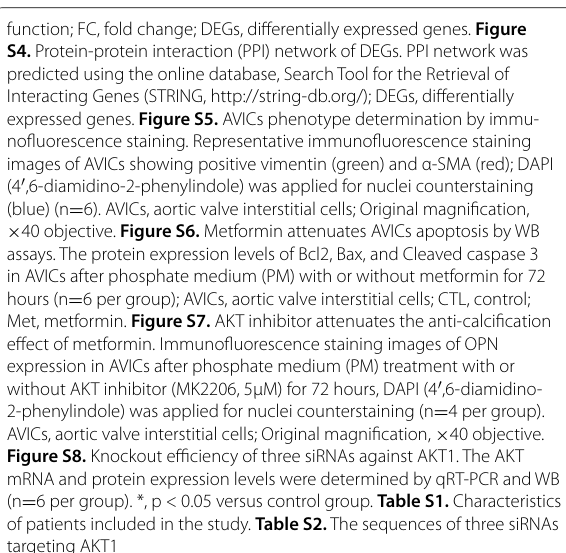
function; FC, fold change; DEGs, differentially expressed genes. Figure S4. Protein-protein interaction (PPI) network of DEGs. PPI network was predicted using the online database, Search Tool for the Retrieval of Interacting Genes (STRING, http://string-db.org/); DEGs, differentially expressed genes. Figure S5. AVICs phenotype determination by immu- nofluorescence staining. Representative immunofluorescence staining images of AVICs showing positive vimentin (green) and α-SMA (red); DAPI (4 ′ ,6-diamidino-2-phenylindole) was applied for nuclei counterstaining (blue) (n 6). AVICs, aortic valve interstitial cells; Original magnification, = 40 objective. Figure S6. Metformin attenuates AVICs apoptosis by WB × assays. The protein expression levels of Bcl2, Bax, and Cleaved caspase 3 in AVICs after phosphate medium (PM) with or without metformin for 72 hours (n 6 per group); AVICs, aortic valve interstitial cells; CTL, control; = Met, metformin. Figure S7. AKT inhibitor attenuates the anti-calcification effect of metformin. Immunofluorescence staining images of OPN expression in AVICs after phosphate medium (PM) treatment with or without AKT inhibitor (MK2206, 5μM) for 72 hours, DAPI (4 ′ ,6-diamidino- 2-phenylindole) was applied for nuclei counterstaining (n 4 per group). = AVICs, aortic valve interstitial cells; Original magnification, 40 objective. × Figure S8. Knockout efficiency of three siRNAs against AKT1. The AKT mRNA and protein expression levels were determined by qRT-PCR and WB (n 6 per group). *, p < 0.05 versus control group. Table S1. Characteristics = of patients included in the study. Table S2. The sequences of three